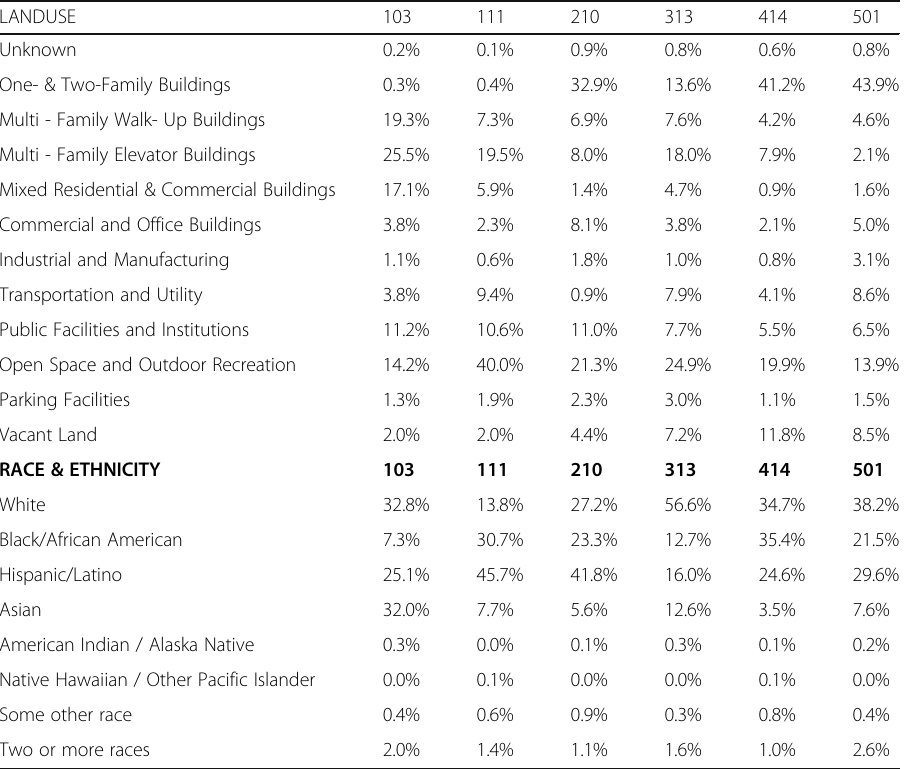
Table 3 Land use and race distributions in percentage across the selected CDs, according to MapPLUTO (2018) and ACS (2013 – 2017)